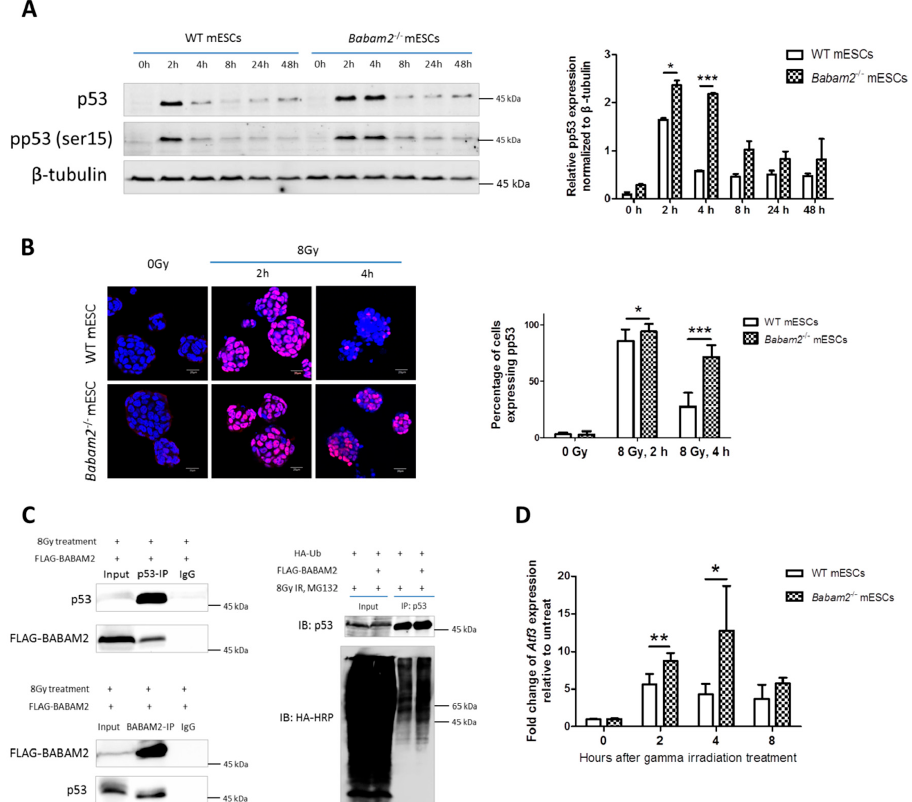
Figure 4. p53 are expressed at a higher level and for a longer period in Babam2 − / − than WT mESCs after 8 Gy gamma irradiation treatment. ( A ) Western blot showing p53 and pp53 (ser15) expressions in WT and Babam2 − / − mESCs at chosen time points after 8 Gy treatment. High expressions of p53 and pp53 were observed 4 h after gamma irradiation in Babam2 − / − mESCs but not in WT mESCs. Relative expression of pp53 normalized against β -tubulin is presented in the bar chart. Data represent the mean ± SD of three independent experiments. * indicates p < 0.05, two-sided unpaired t -test. *** indicates p < 0.001, two-side unpaired t -test. ( B ) Immunofluorescence staining for pp53 in Babam2 − / − and WT mESCs with or without gamma irradiation treatment. The nuclei were counterstained with DAPI. Scale bar = 20 μ m. At least 300 cells from 10 colonies of mESCs were analyzed. The graph represents the mean ± SD. * indicates p < 0.05, two-sided unpaired t -test. ** indicates p < 0.001, two-sided unpaired t -test. ( C ) Interaction between p53 and overexpressed FLAG-BABAM2 was confirmed by co-immunoprecipitation of BABAM2 with the p53-specific antibody. p53 was also co-immunoprecipitated with overexpressed FLAG-BABAM2 using anti-BABAM2 antibodies in the 293FT cell line. p53 ubiquitination in 293FT cells with and without BABAM2 overexpression was analyzed by Western blot analysis and detected with HRP-tag anti-HA antibodies. ( D ) RT-qPCR analysis revealed the fold change in the p53-targeted gene, Atf3, expression relative to untreated Babam2 − / − and WT mESCs after 8 Gy treatment. Data represent the mean ± SD of three independent experiments. *, p < 0.05, **, p < 0.005, two-sided unpaired t -test. We used co-immunofluorescence staining to investigate p53, OCT4, SOX2, and NANOG expressions, 4 h post-irradiation treatment (Figure 5). Immunofluorescence imaging revealed that pp53 expressions were almost abolished in WT mESCs but still remained strongly expressed in nuclei of Babam2 − / − mESCs. We then examined the consequence of high pp53 expressions in Babam2 − / − mESCs